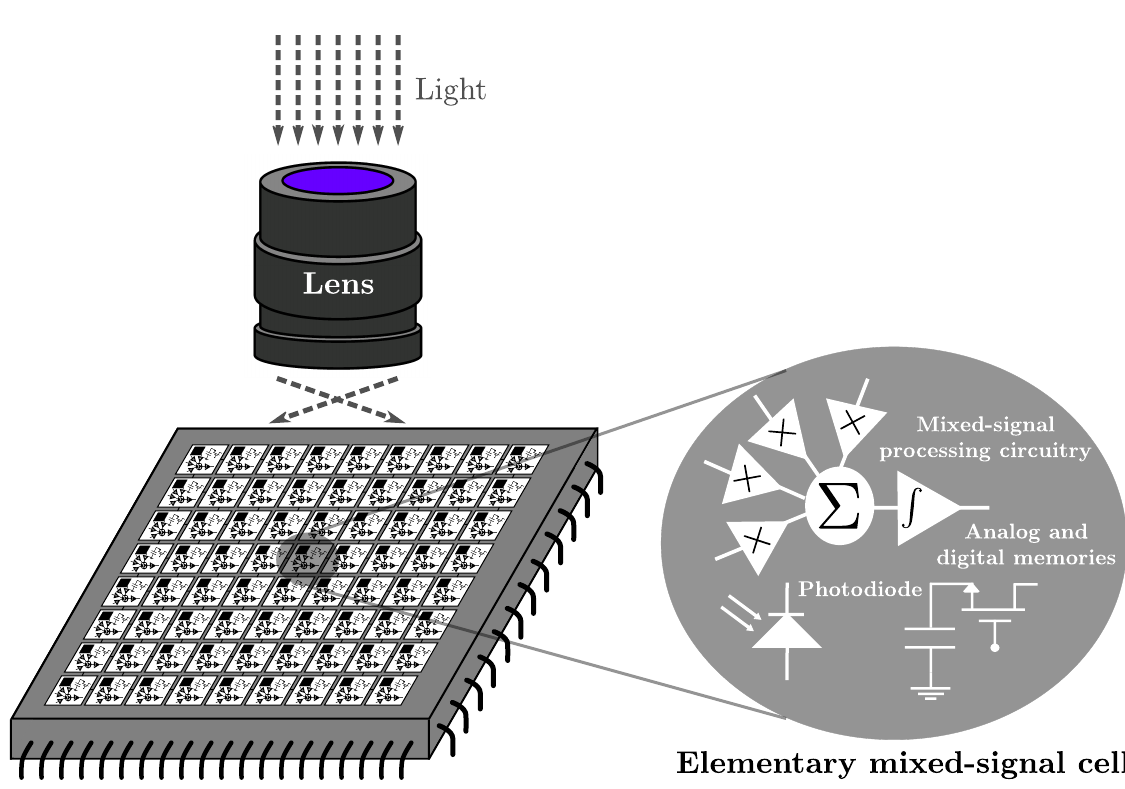
Figure 2. Sensing-processing vision chips capture and process images simultaneously at the focal plane by means of an array of interconnected elementary mixed-signal cells, also known as multi-functional